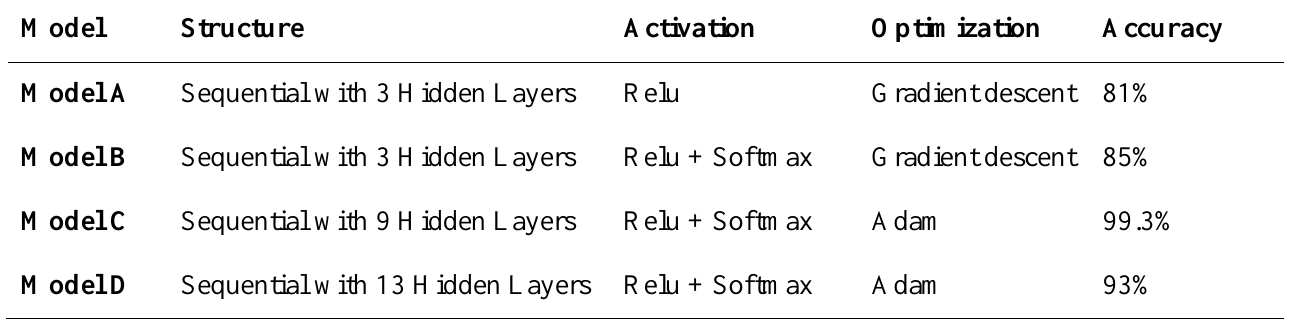
Table 2. Models developed